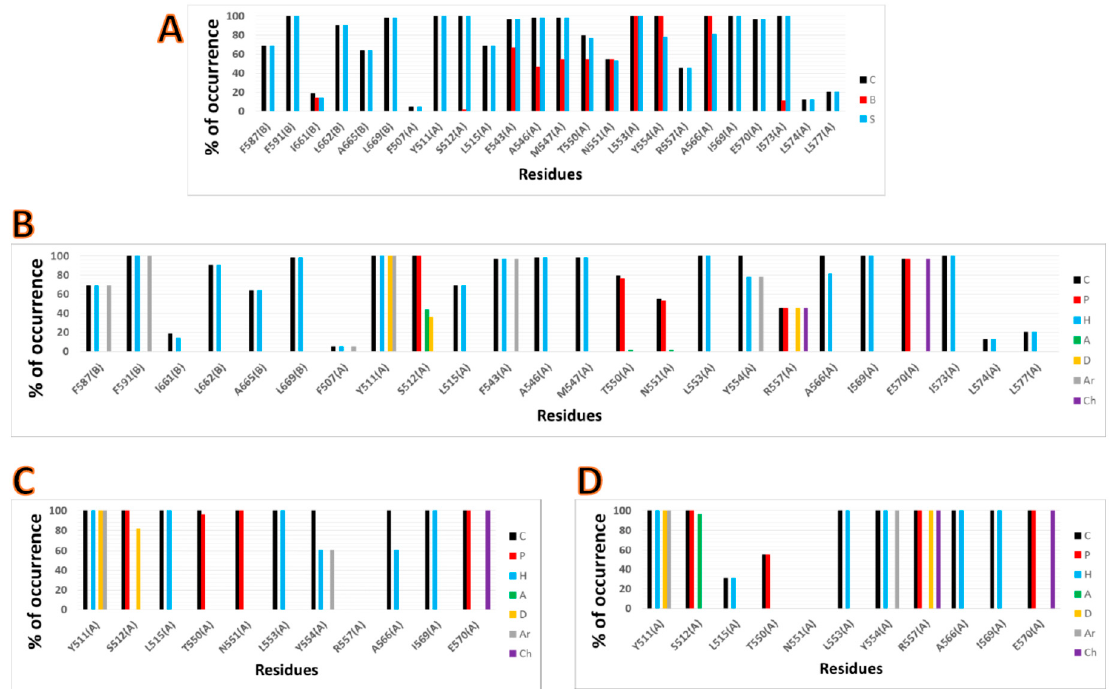
Figure 4. Occurrences of the interaction types at the TRPV1–ligand binding interface for the complexes obtained via docking. The percentages of occurrences of contacts C, interactions with the backbone of the residue B, and interactions with the side chain of the residue S for the 64 complexes ( A ). The percentages of occurrences of chemical interactions: contacts C, polar P, hydrophobic H, HBs where the residue is acceptor A, HBs where the residue is donor D, aromatic Ar, and electrostatic with charged groups Ch for the 64 complexes ( B ), for compounds from series A ( C ), and compounds from series B ( D ).